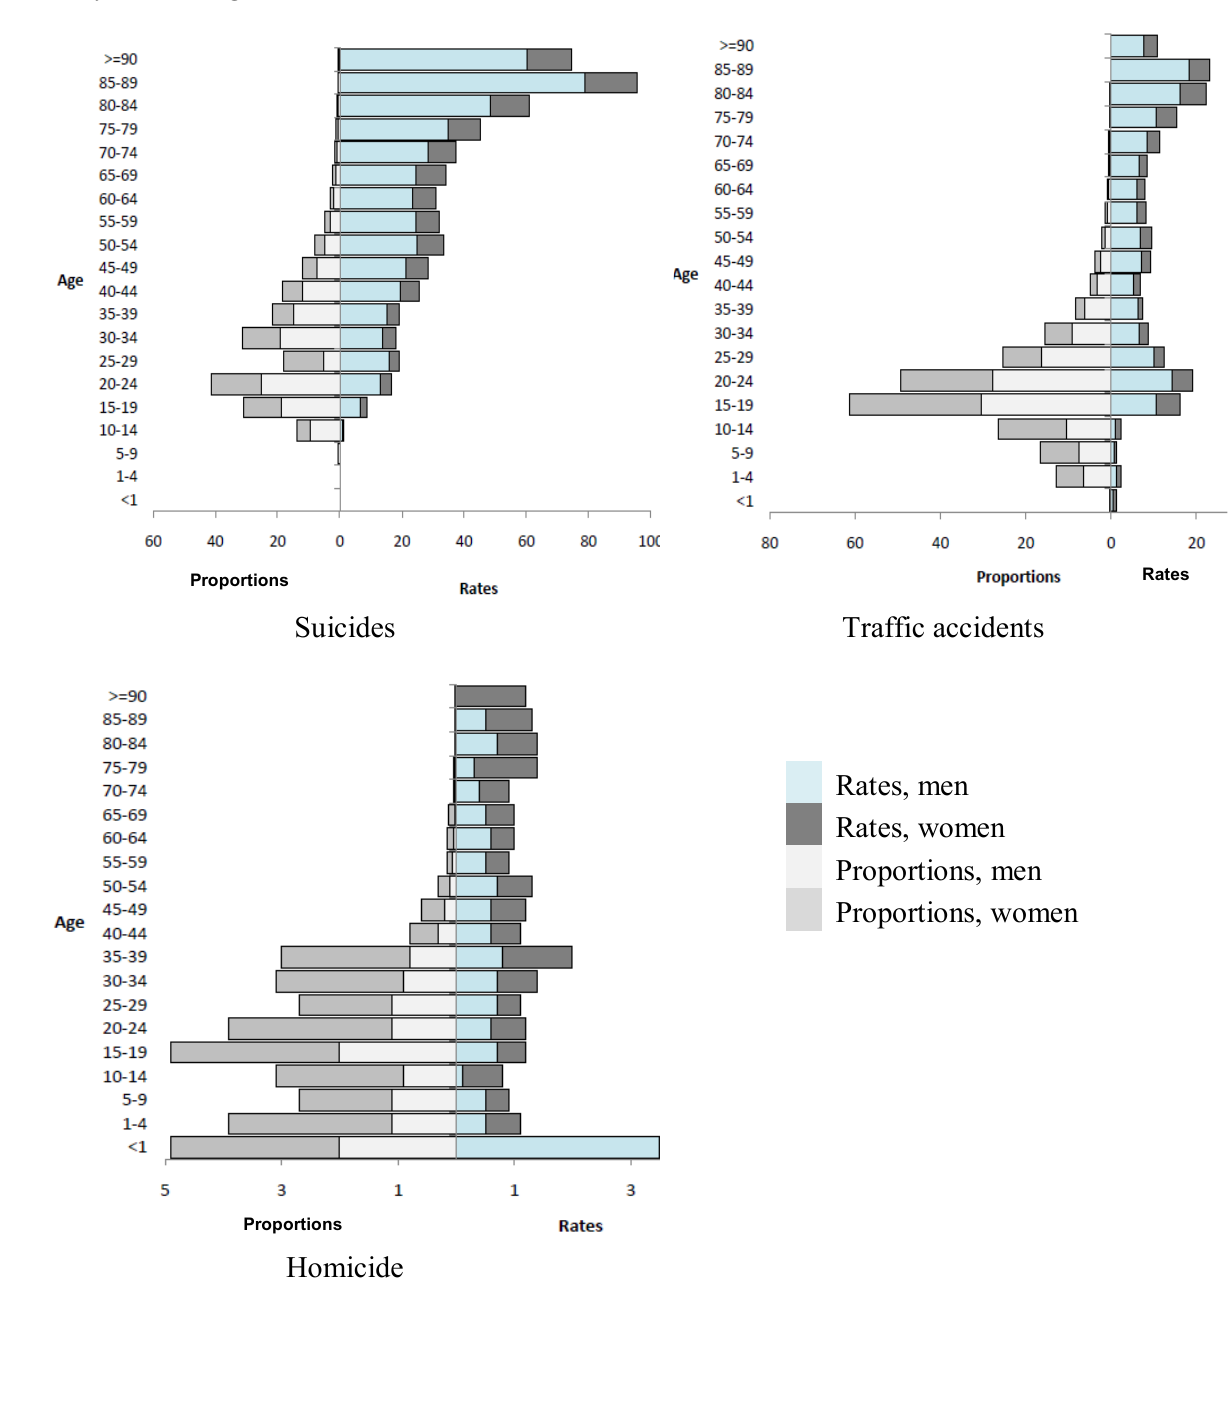
causes of death) of suicide, traffic accidents, and homicide in Germany (2010), stratified by sex and